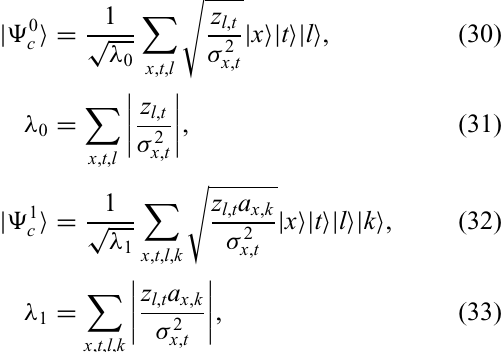
FIG. 3. Circuit diagrams of the fault-tolerant oracles SEL 0 , SEL 1 , PREP 0 , and PREP 1 described in this text. See the text for details. Black circles on multiqubit registers denote complex con- trol procedures. Square boxes denote classical input to the system via quantum read-only memory (QROM) and coherent alias sam- pling (CAS) [15]. Subscripts are omitted from gates for ease of reading. The dashed circles on the control for U in the SEL a cir- cuits indicate control that is only needed if the time evolution during an experiment changes between